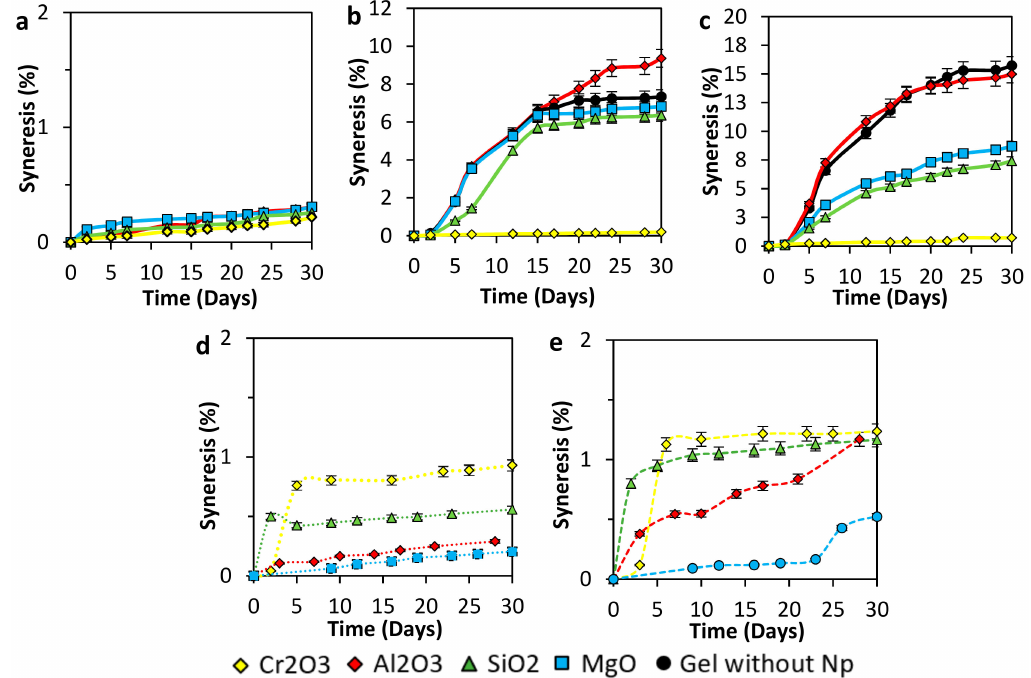
Figure 6. Syneresis development of ( a ) 4000 mg · L − 1 , ( b ) 6000 mg · L − 1 , and ( c ) 8000 mg · L − 1 of polymer concentration of acrylamide sodium acrylate copolymer / chromium III acetate gel systems at a